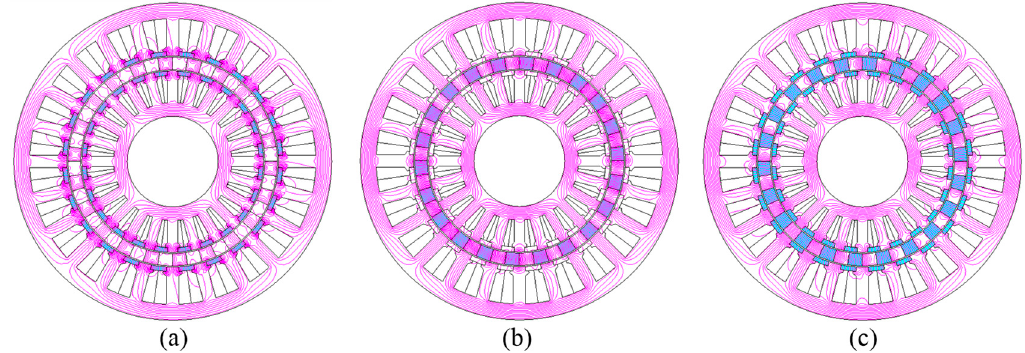
Figure 2. No-load magnetic field distributions. ( a ) Excited by double-stator (DS) permanent magnets (PMs); ( b ) excited by rotor PMs; ( c ) excited by DS PMs and rotor PMs together.